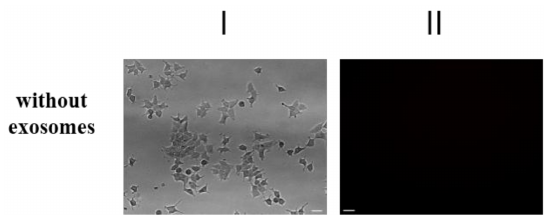
Figure 3. Transferring of fluorescent-labeled compounds by exosomes. Exosomes were stained by fluorescent drug (CellTracker™ Red CMPTX Dye) in according to the manufacturer’s procedure, then washed twice by the ultracentrifugation 100,000 × g and incubated with MCF-7 cells. As a control labeled exosomes after sonication were used. The non-specific labeling of cell was checked by the fluorescent dye which was spun alone. The efficiency of dyeing exosome incorporation was checked with fluorescent microscope Nikon Eclipse Ti-E (Plan 10 × /0.25; ORCA-ER camera by Hamamatsu Photonics; NIS-Elements AR 2.3 software by Nikon). Exposition for fluorescence was 4 s. Scale bar 50 µ m. The images of light (I) and fluorescent (II) microscopy are presented.